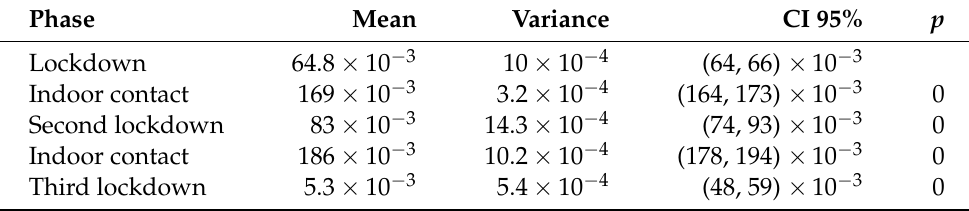
Table 7. Histogram for the mean values of β E at the different stages of lockdown in the